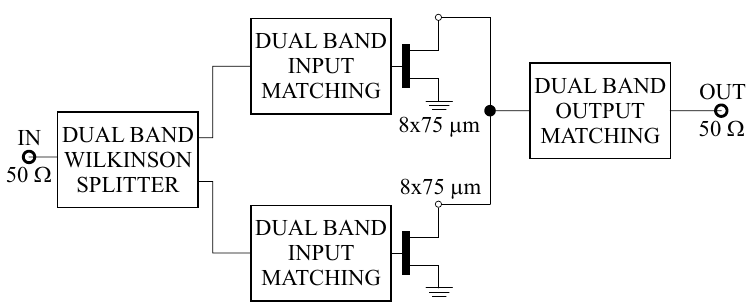
Figure 4. Block scheme of the dual-band PA.